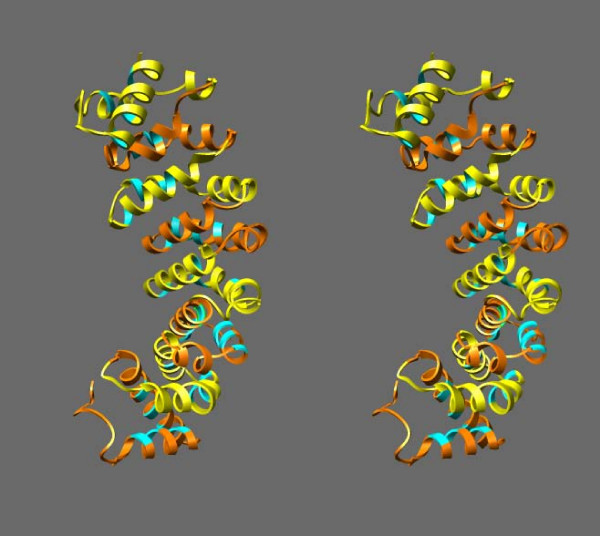
Stereo pair of the ribbon representation of the 3D structure of model #1 from I-TASSER server. The chain runs N-terminal to C-terminal from bottom to top in the figure. Repeats 1, 3, 5, and 7 are in orange; repeats 2, 4, 6, and 8 are in yellow; the residues highlighted in Figure 2 are in green. The drawing was made using Chimera [53].